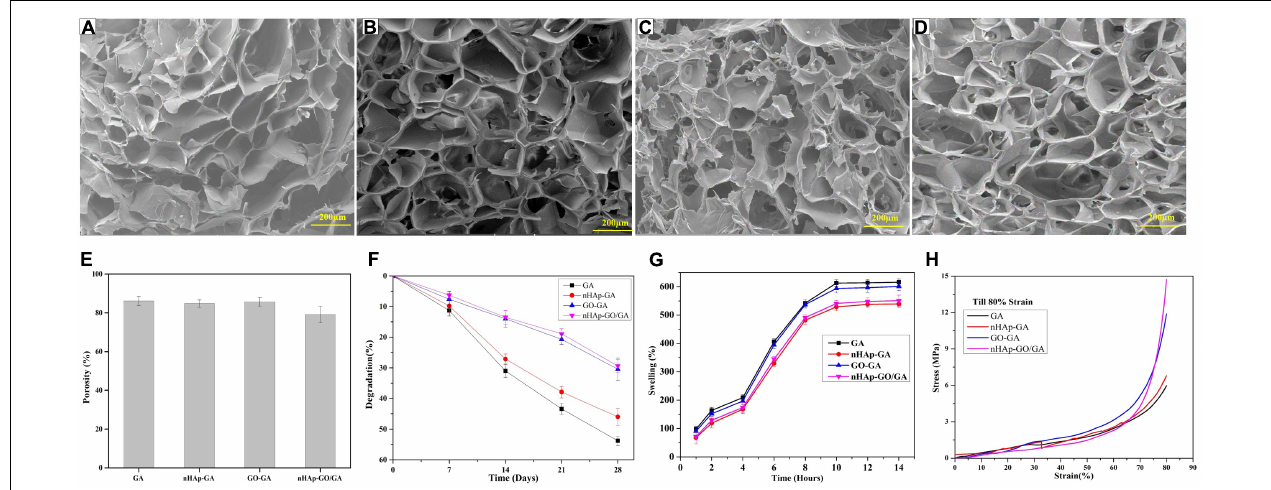
FIGURE 2 | Physical characterization of GA, nHAp-GA, GO-GA, and nHAp-GO/GA nanocomposite scaffolds: FESEM image of GA (A) , nHAp-GA (B) , GO-GA (C) , and nHAp-GO/GA (D) . Porosity (E) , degradation (F) , swelling behavior (G) , and Stress–strain curve by compressive test (H) .